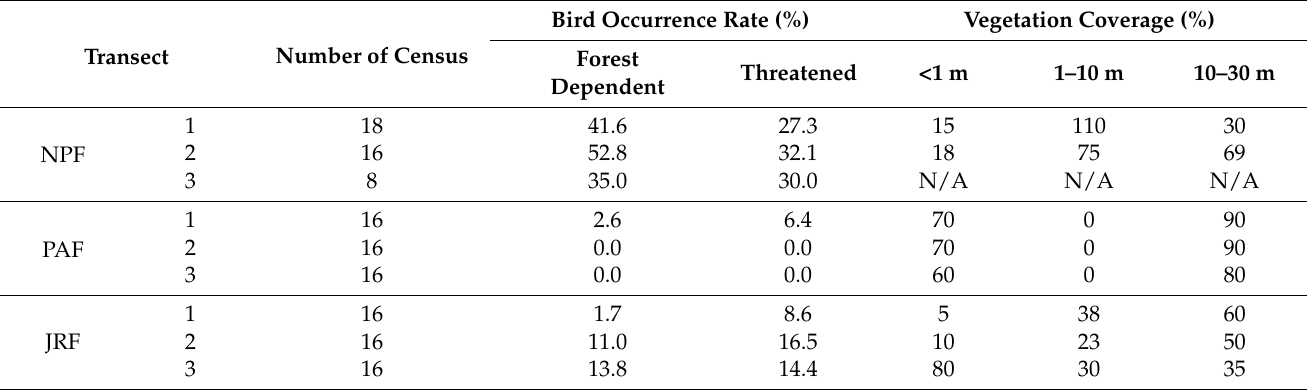
Table 2. Number of bird censuses, bird occurrence rate of forest-dependent and threatened species, and vegetation coverage in each forest layer on each survey transect. No vegetation survey was conducted in